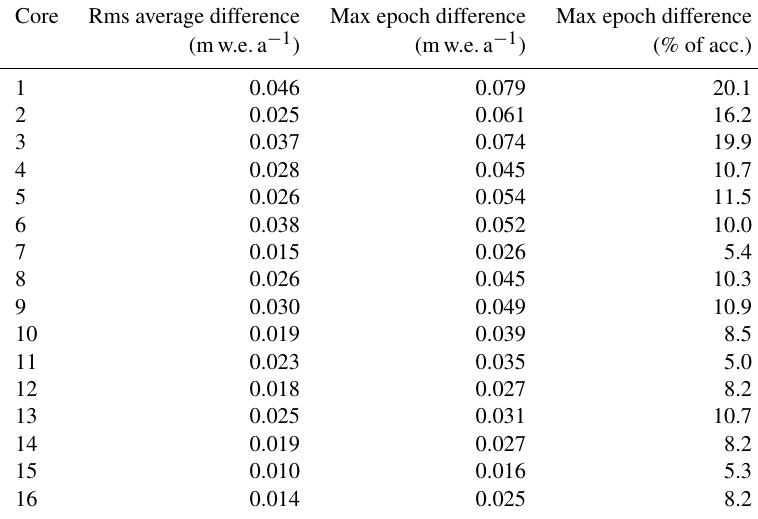
Table 1. Difference between accumulation rates at each GreenTrACS core site calculated using Herron–Langway profiles and firn core density information. Core